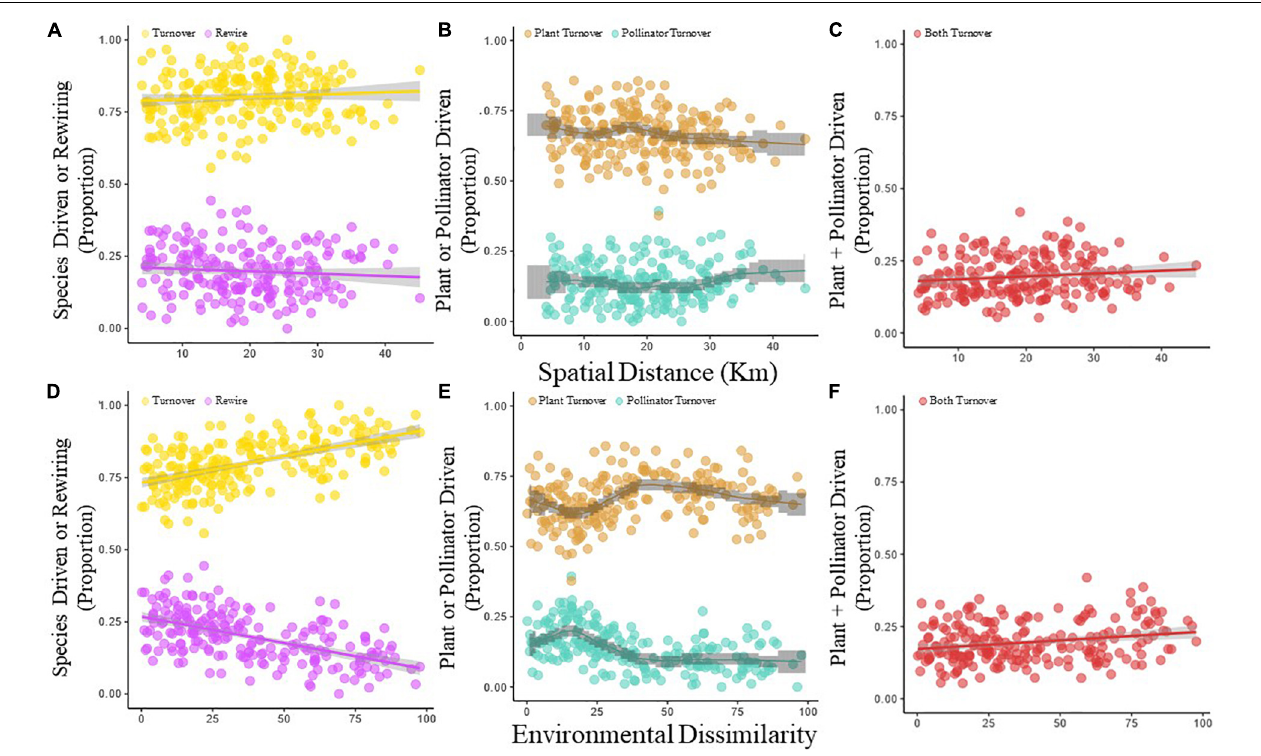
FIGURE 4 | The proportion of the total interaction turnover that can be labeled as either species-driven interaction turnover (yellow points and yellow line) or rewiring (purple points and purple line) changes in relation to geographical distance (A) or the environmental dissimilarity (B) between paired networks. The proportion of the species–driven interaction turnover that can be ascribed as pollinator-driven (blue points and blue line) and plant-driven (orange points and orange line) as a function of spatial distance (C) or environmental dissimilarity (D) . Proportion of species–driven interaction turnover that is caused by a combined turnover of both plants and pollinators (pollinator + plant-driven) in relation to geographical distance (E) and environmental dissimilarity (F)